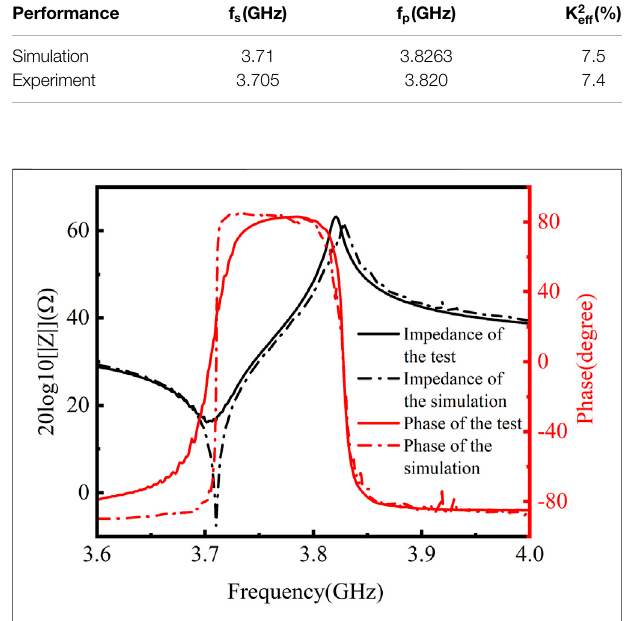
FIGURE 9 | Comparison of the test data and simulated